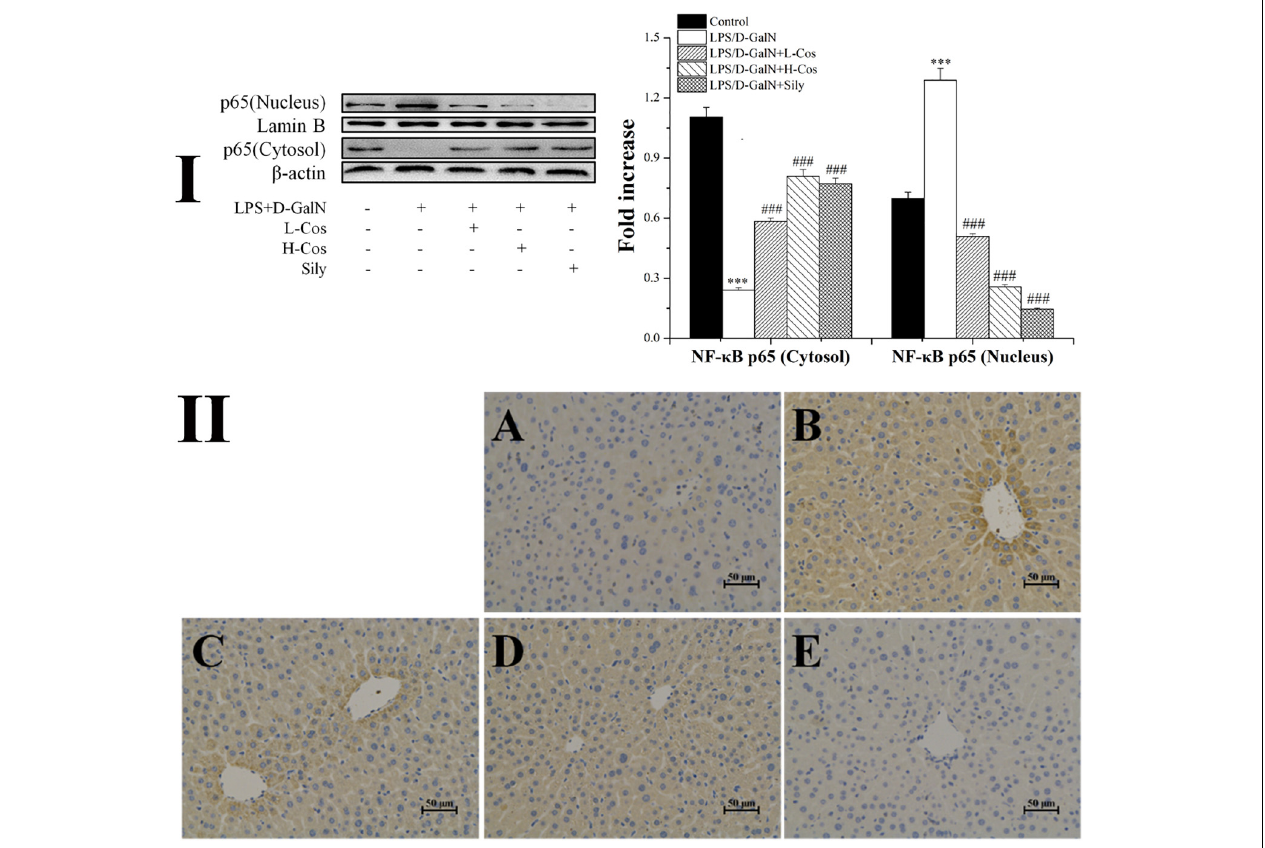
FIGURE 7 | Effects of cos on the expression of p65 protein. (I) Western blot analysis of cytosol and nucleus p65 proteins. (II) Immunohistochemistry analysis of NF- κ B (p65). (II-A) Control; (II-B) LPS/ D -GalN (LPS 50 µ g/kg; D -GalN: 400 mg/kg); (II-C) LPS/ D -GalN + L-cos ( II-B + cos 20 mg/kg); (II-D) LPS/ D -GalN + H-cos ( II-B + cos 40 mg/kg); (II-E) LPS/ D -GalN + sily ( II-B + sily 20 mg/kg). The density values of the western blot were normalized for β -actin and Lamin B. ∗∗∗ P < 0.01 vs. control group, ### P < 0.01 vs. LPS/ D -GalN